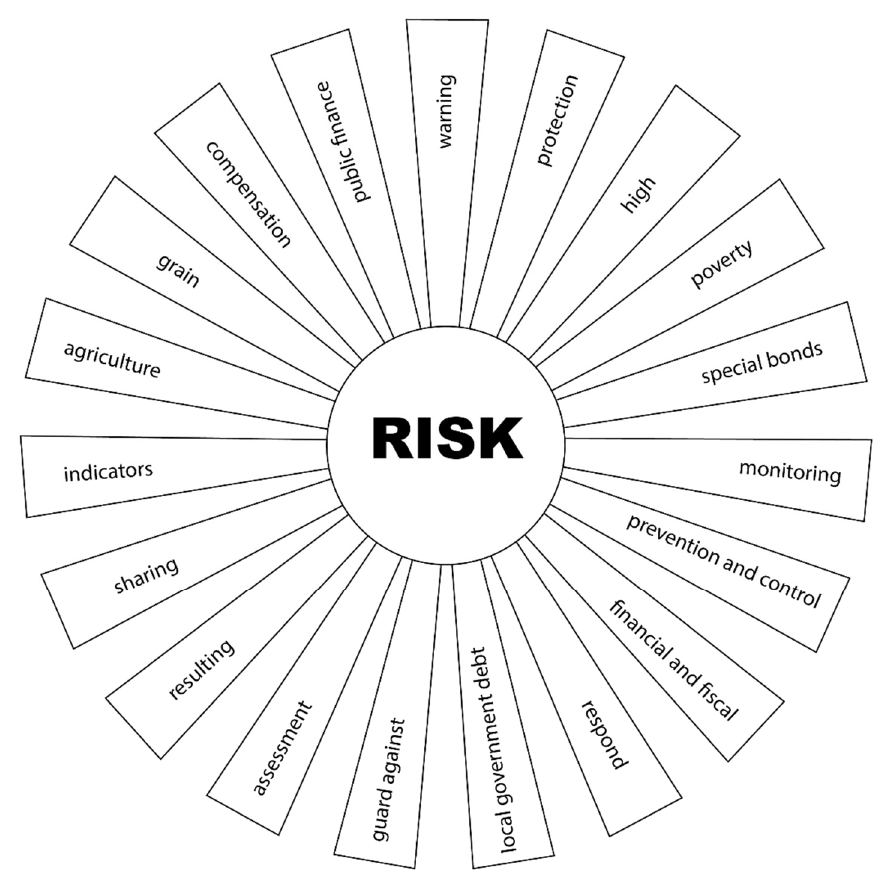
Figure 3. The network of the form “risk” of China Central and Local Government.